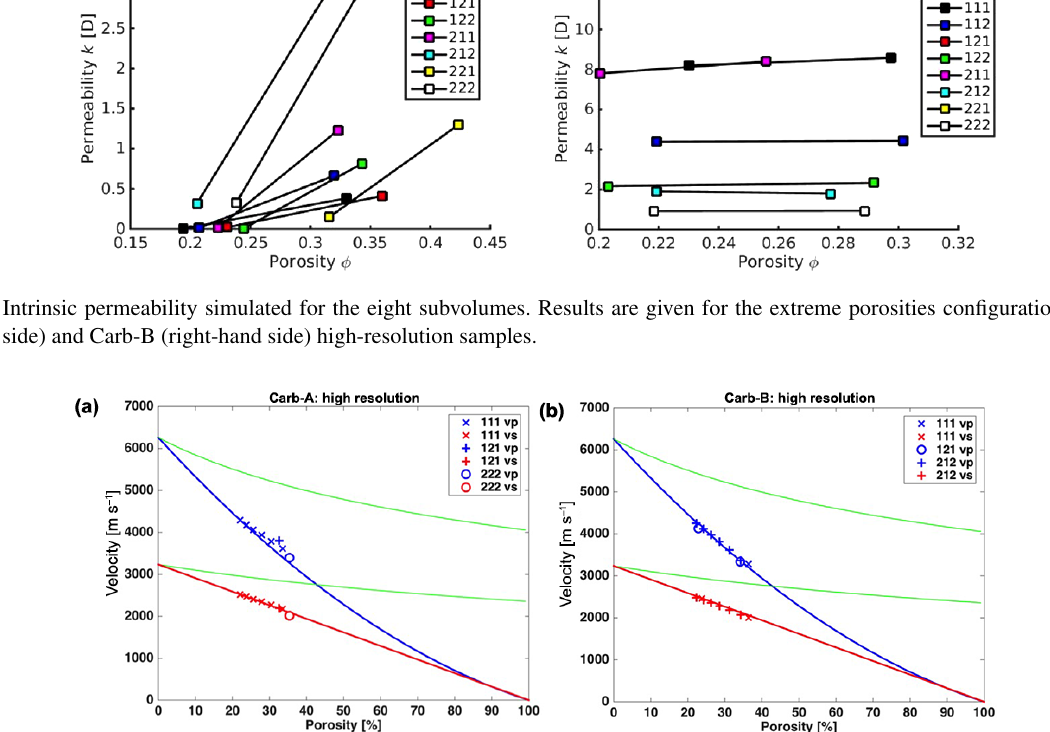
Figure 8. Effective P - and S -wave velocities (red and blue dots, respectively) for simulations based on a two-phase segmentation. The results were obtained for a random selection of subvolumes of Carb-A (left-hand side) and Carb-B (right-hand side). The blue and red lines are the velocity trends given by Eqs. (4) and (5). The green lines are derived by using the upper Hashin–Shtrikman bounds. For details please refer to the